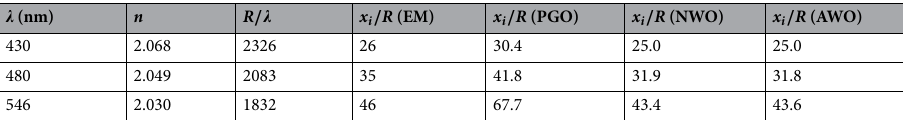
Table 1. Comparison of the experimental measurements (EM) of image location x i / R for a ball with R = 1 mm at different operating wavelength (cid:31) and the predictions for x i / R of various theoretical approaches based on the refractive indices n of LASNF35 glass at the specified wavelengths: paraxial geometrical optics (PGO), numerical wave optics (NWO), and simple analytical result (10) obtained from WO (AWO).